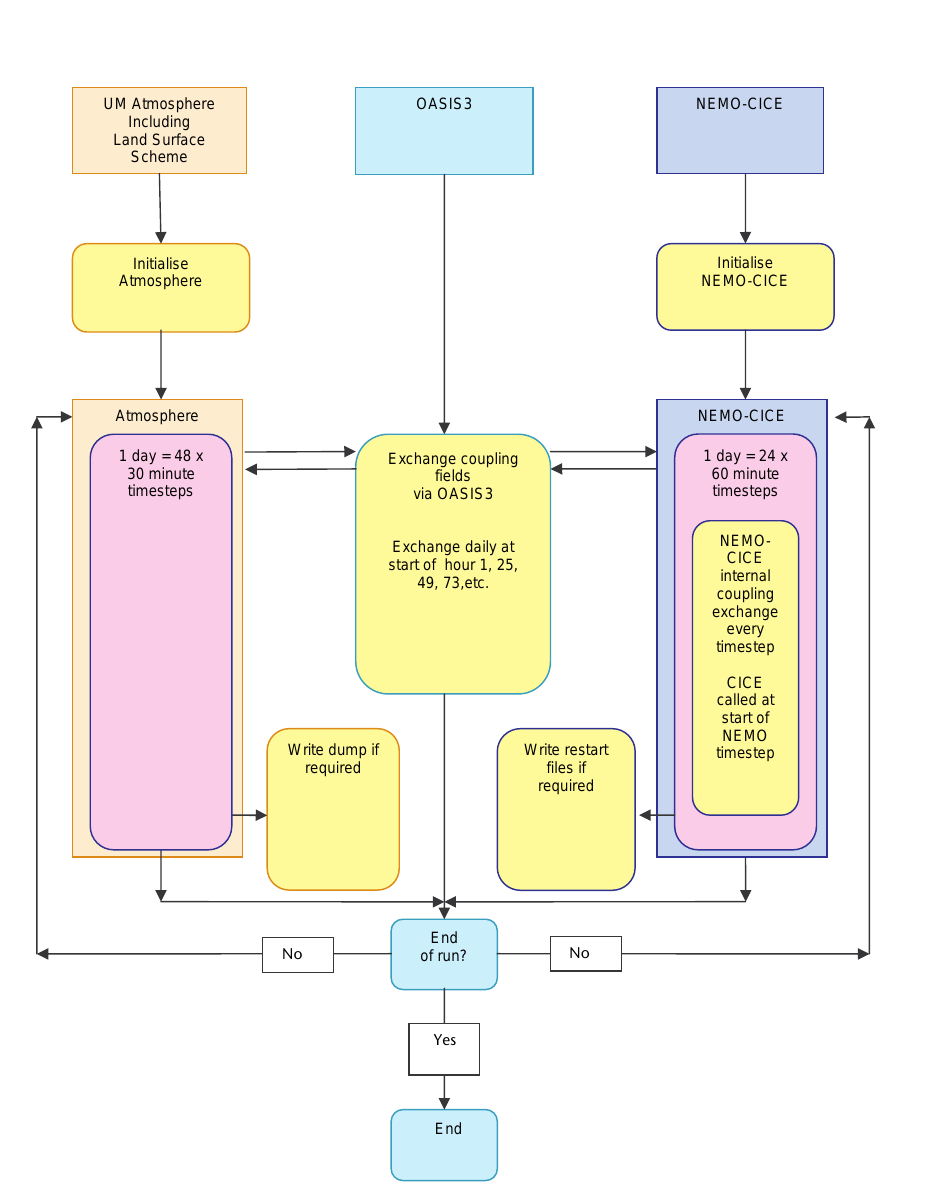
Fig. 3. Schematic representation of the sequence of events in coupled models highlighting the critical positioning of the coupling exchanges and creation of model restart and dump files in relation to each component.